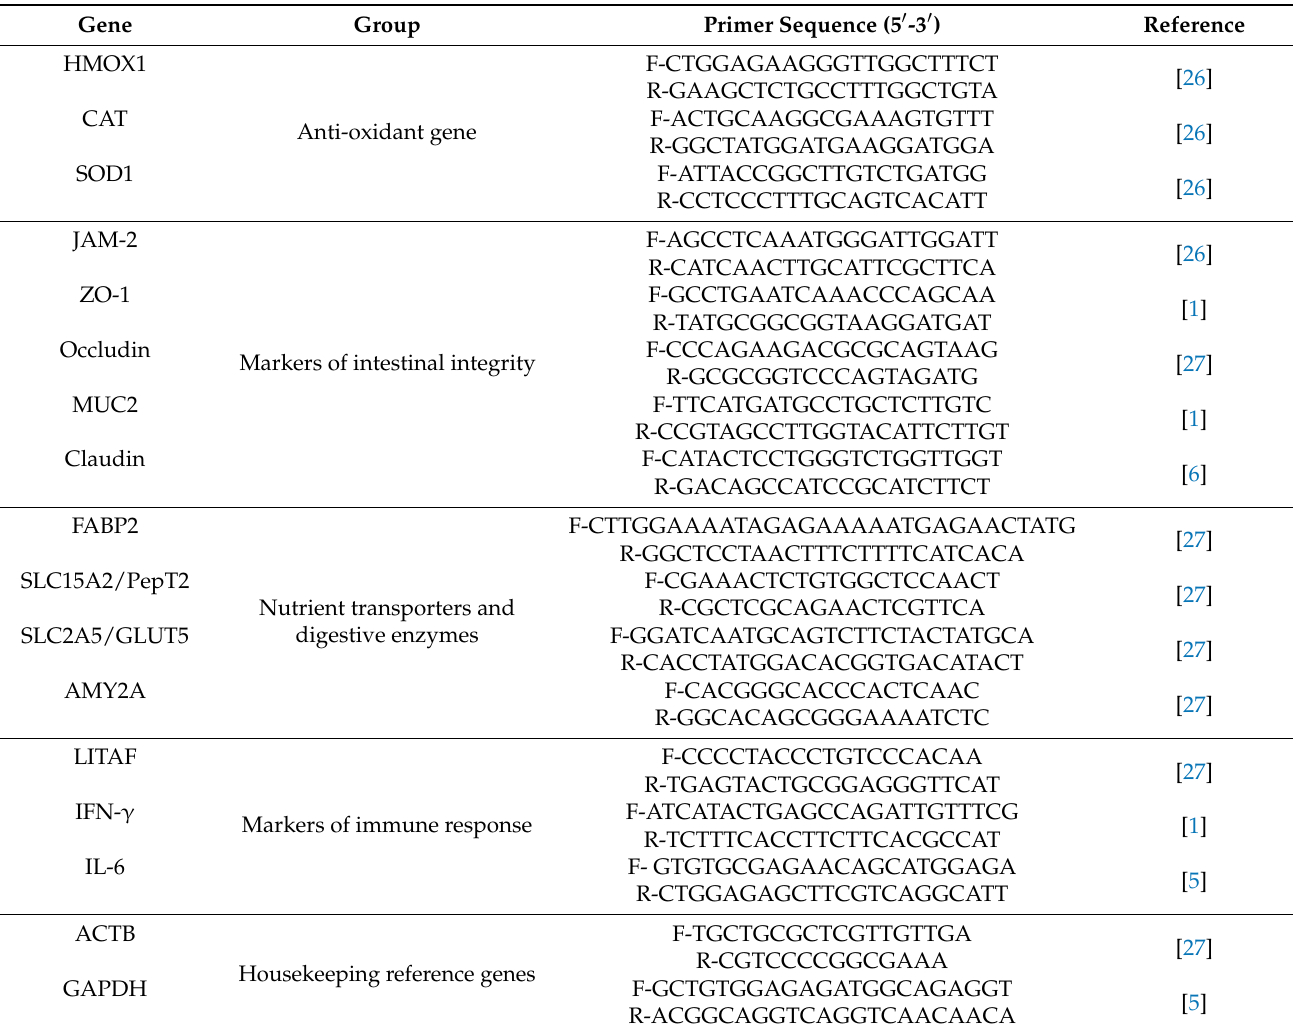
Table 2. List of primers used in the present